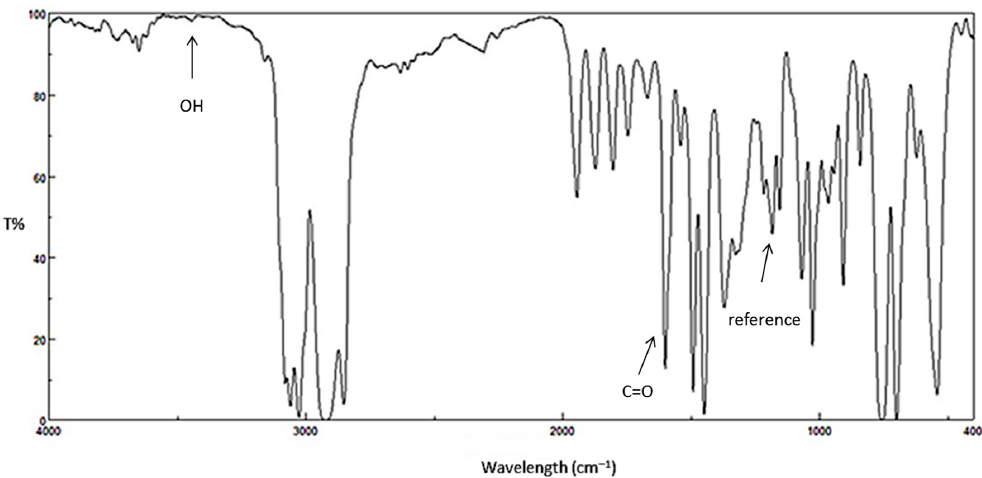
Figure 2. FTIR spectrum for PS film before irradiation.